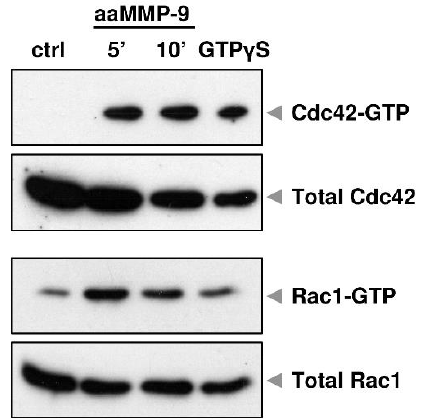
Figure 1. MMP-9 proteolytic activity causes Cdc42 and Rac1 activation in cultured cortical neurons. Cells were treated with autoactivaiting matrix metalloproteinase 9 (aaMMP-9) for 5 and 10 min and the activity of Rho-GTPases was analyzed using a pull-down assay. Western blots show levels of the activated form (coupled with GTP) and total levels of Cdc42 and Rac1. GTPγS served as a positive control for pull-down assay.